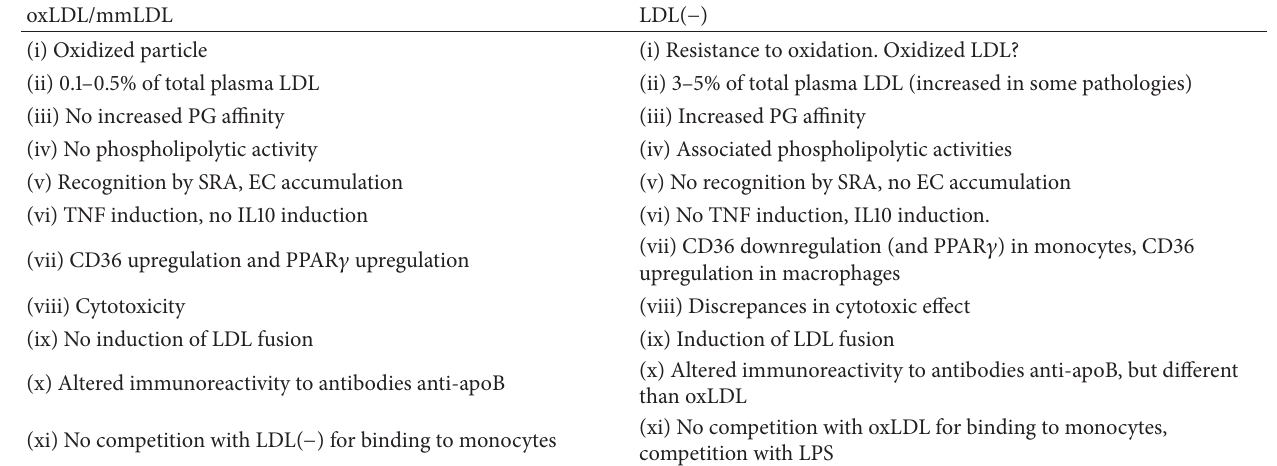
Table 1: Differences in the properties of oxLDL/mmLDL and LDL( −